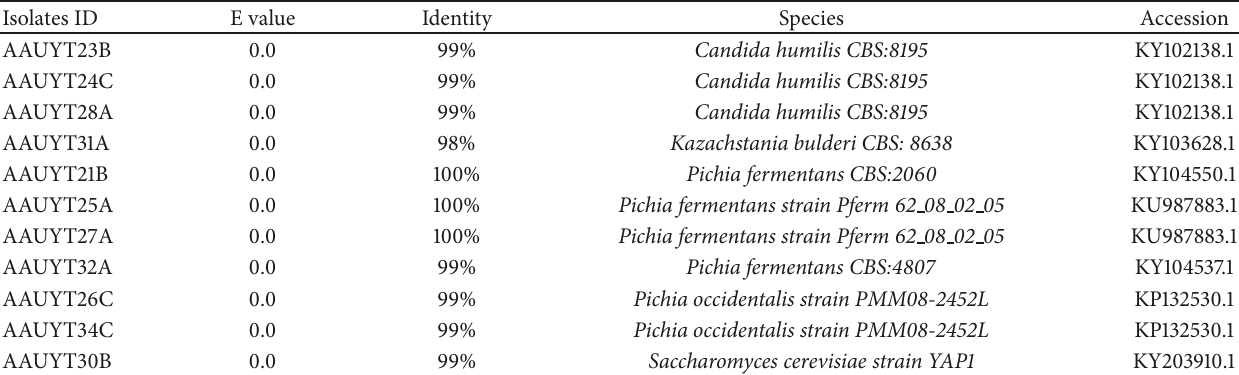
Table 2: Isolates on the basis of similarity to the partial ITS DNA